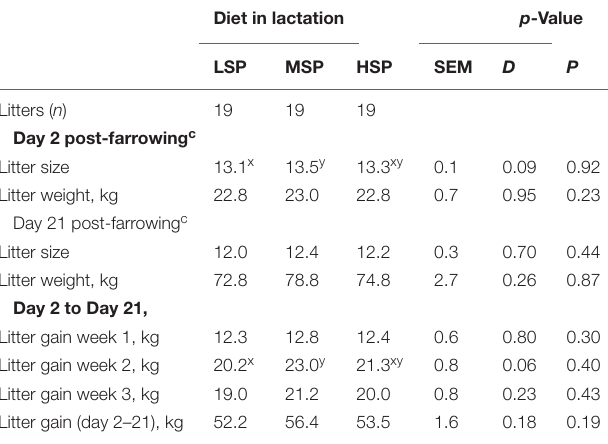
TABLE 4 | Effects of slow protein level in the lactation diet and parity on litter gain between Days 2 and 21 post-farrowing, in weeks 1, 2, and 3 post-farrowing (LSmeans ±